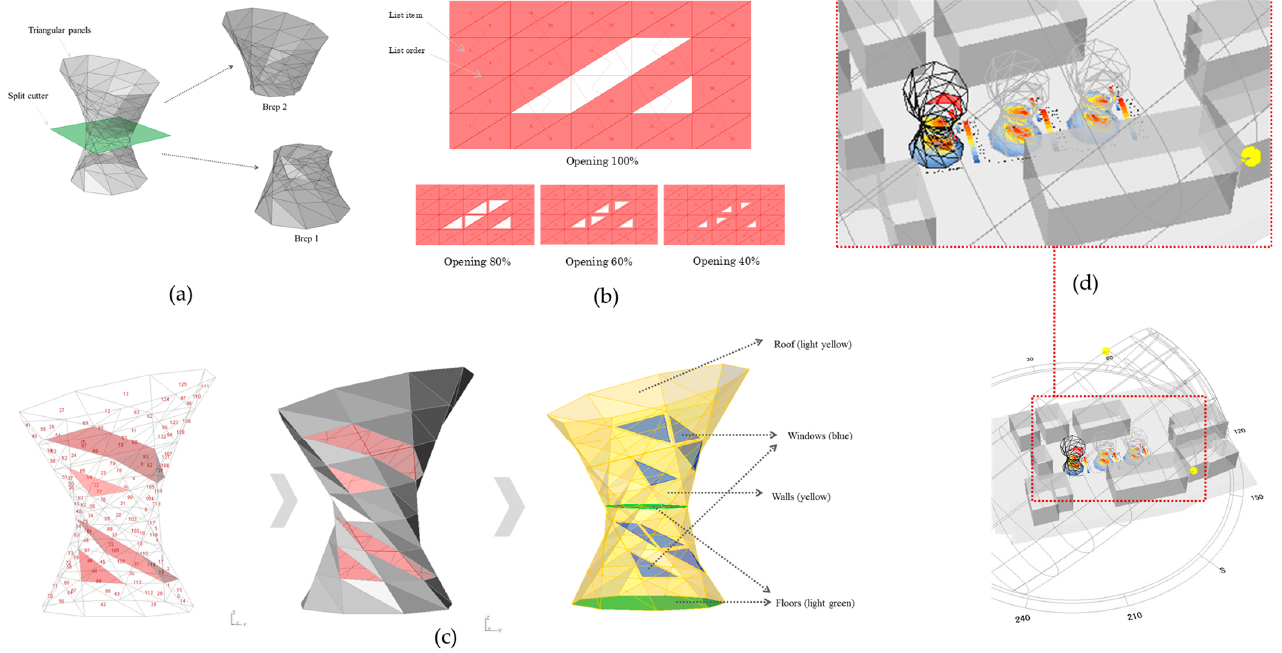
Figure 9. Modeling preparation for daylight analysis: ( a ) split brep to divide zones; ( b ) windows ratio setting; ( c ) windows application in hyperboloid structure; ( d ) daylight analysis and visualization.